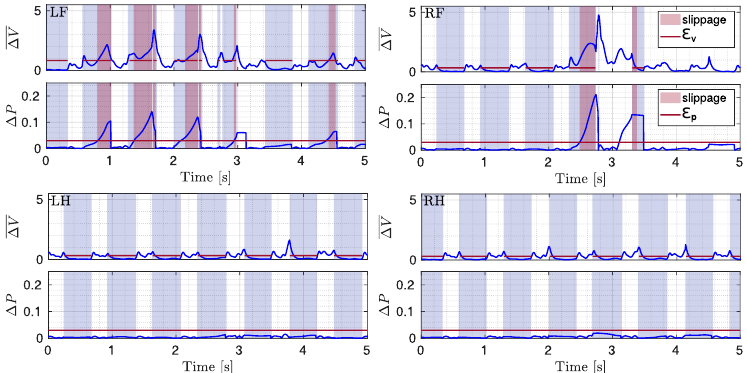
Figure 9. Plots of ∆ V and ∆ P (blue) with respective thresholds (red line) illustrated for the four legs (LF, RF, LH, RH) during a trot gait. The gray shaded area shows stance phases and the red shaded area marks slippage.